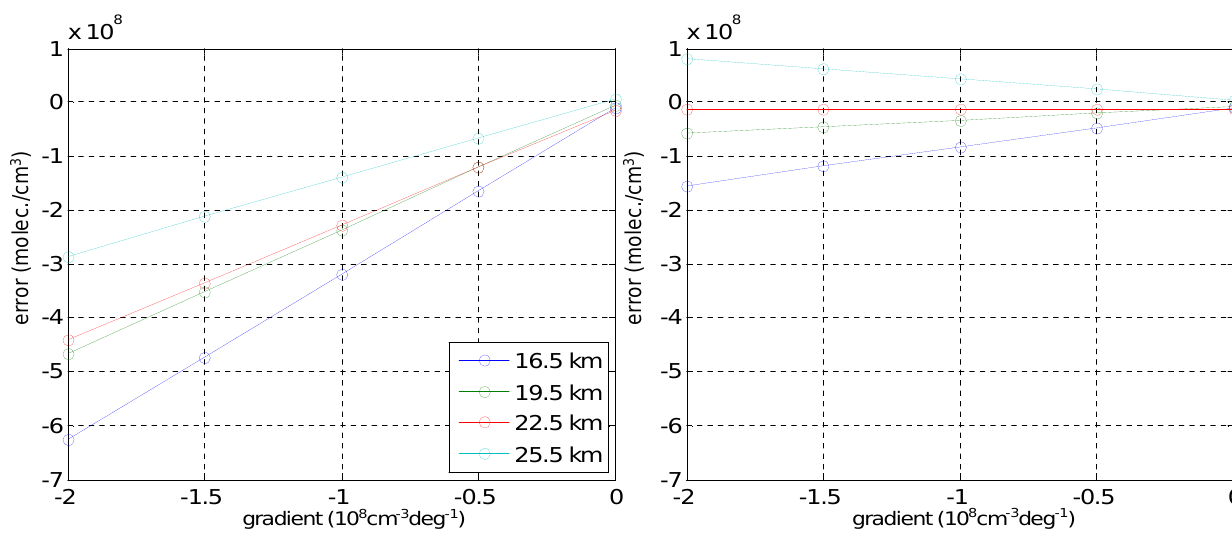
Fig. 13. The systematic error in the retrieved number density of NO 2 as function of the simulated gradient strength between 40 ◦ and 50 ◦ for the 1-D (left) and 2-D (right) retrieval approach. On the x-axis the gradient strength at the peak of the simulated profile (28.5km) is given. The colored lines display the difference to the true simulated values at the respective altitudes (16.5km to 25.5km, see legend).